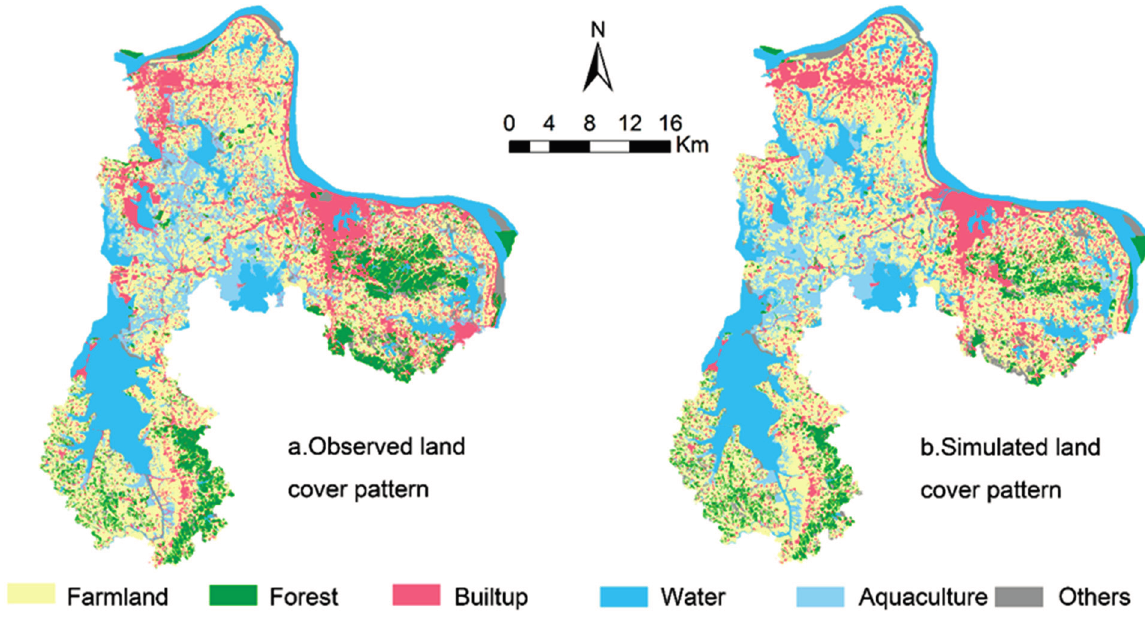
Figure 7. Spatial patterns of empirical and simulated land cover patterns of Ezhou City in